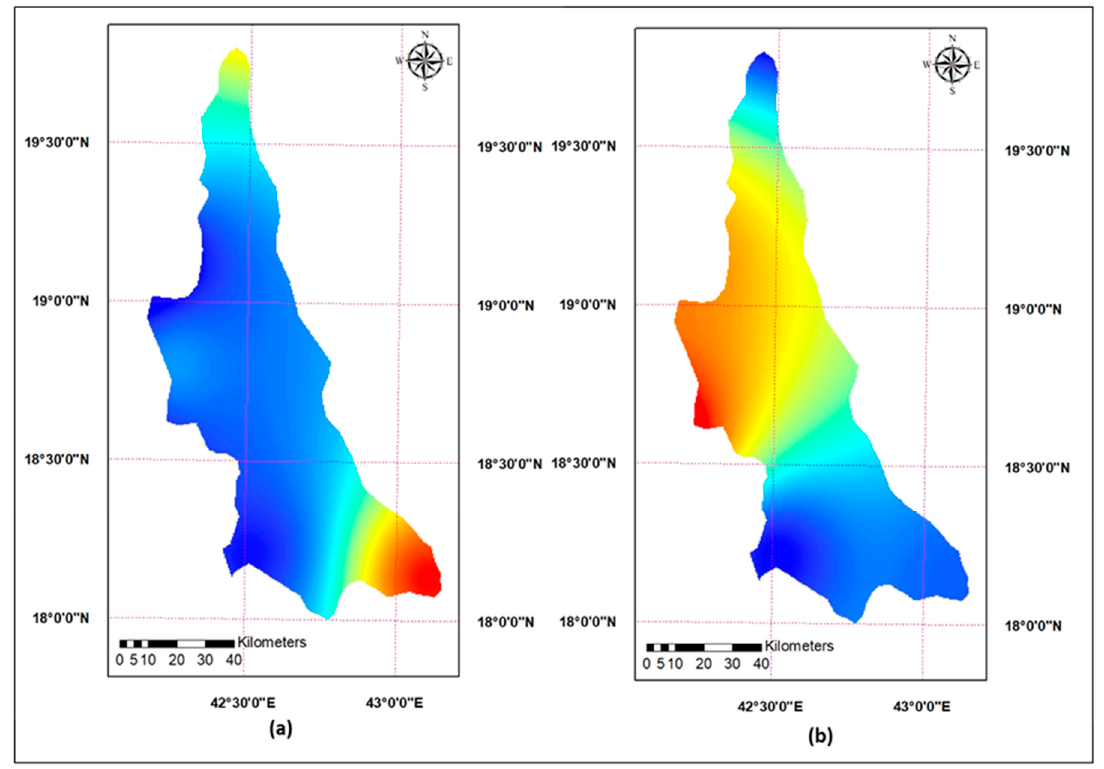
Figure 2. ( a ) Average annual rainfall (1968–2019). ( b ) Spatial trends in the annual rainfall in the study area (1968–2019).